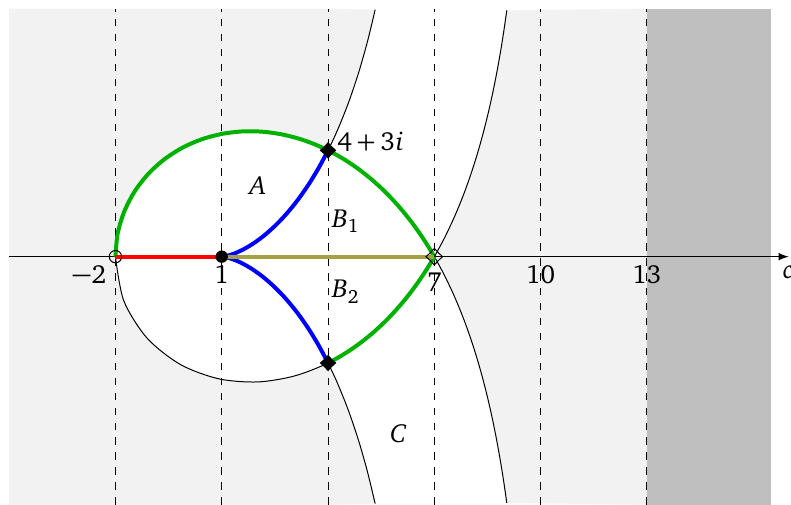
Figure 1.1: The complex Q -plane, and the corresponding strip (white) in the complex (cid:12) 2 -plane according to Eq. (2). The rest of the (cid:12) 2 -plane is in gray, or dark gray for the region f< (cid:12) 2 (cid:20) 0 g where the odd CFT does not exist. Special values of Q and (cid:12) 2 are listed in Table 1.3.